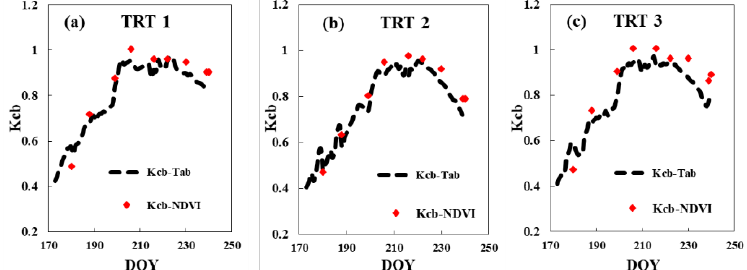
Figure 6. Comparison of the Kcb values calculated by using two methods in three different treatments: TRT 1 ( a ), TRT 2 ( b ) and TRT 3 ( c ). The Kcb-NDVI values were retrieved from regression model (Equations (10) and (11)) of Kcb vs. NDVI, and Kcb-Tab were calculated by the modified FAO-56 method (Equations (4) and (5)).